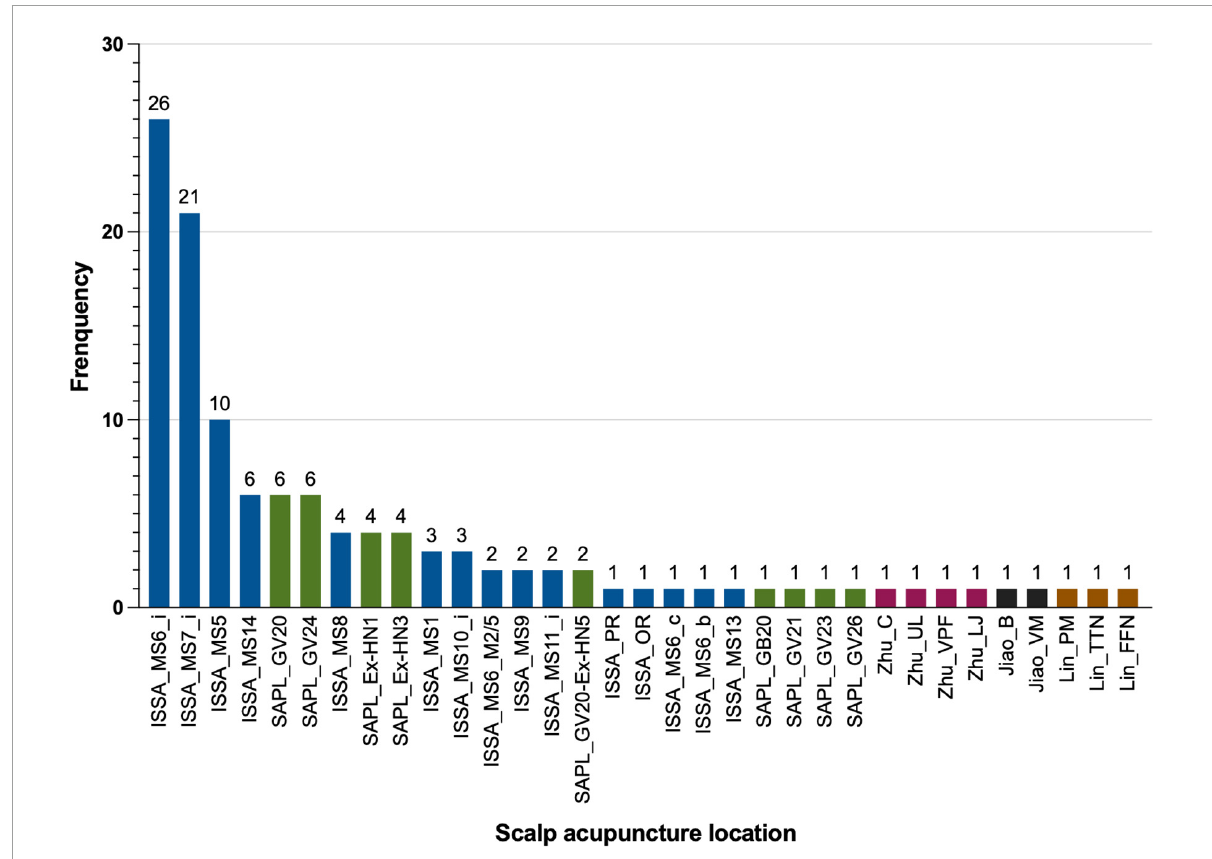
FIGURE3 Distribution of the scalp acupuncture (SA) locations used in the included studies. The full names of the abbreviations of the SA locations are listed in Figure 1 . Blue: International Standard Scalp Acupuncture (ISSA). Green: WHO Standard Acupuncture Point Locations (SAPL). Pink: Zhu’s style SA. Black: Jiao’s style SA. Brown: Lin’s style